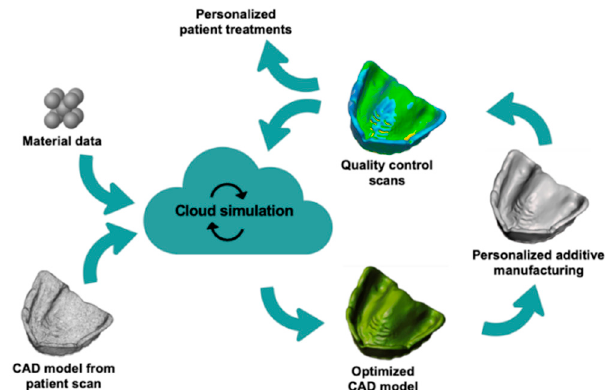
Figure 2. Implemented workflow for producing personalized medical tools through additive manufacturing and integrated self-learning simulation to overcome material-based warpage challenges. CAD: computer-aided design.